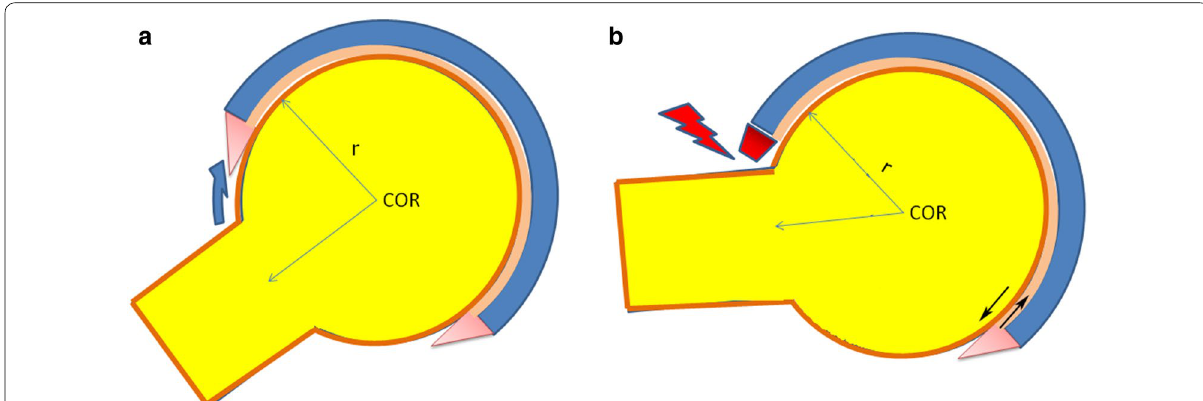
Fig. 3 Pincer FAI. The rim-to-neck collision is geometrically determined and represents a firm endpoint for joint range of motion ( COR center of rotation, r radius). a Neutral joint position; b end range of motion